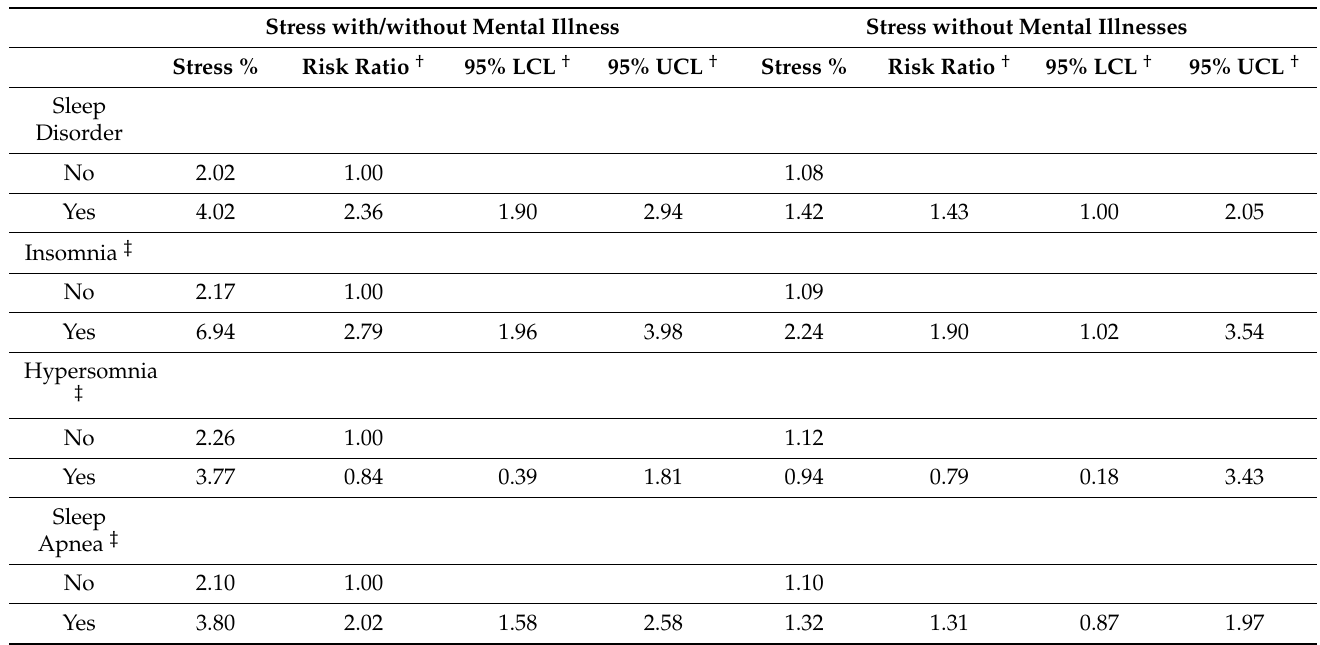
Table 3. Risk of Stress in Contract Holders According to Sleep Disorders,